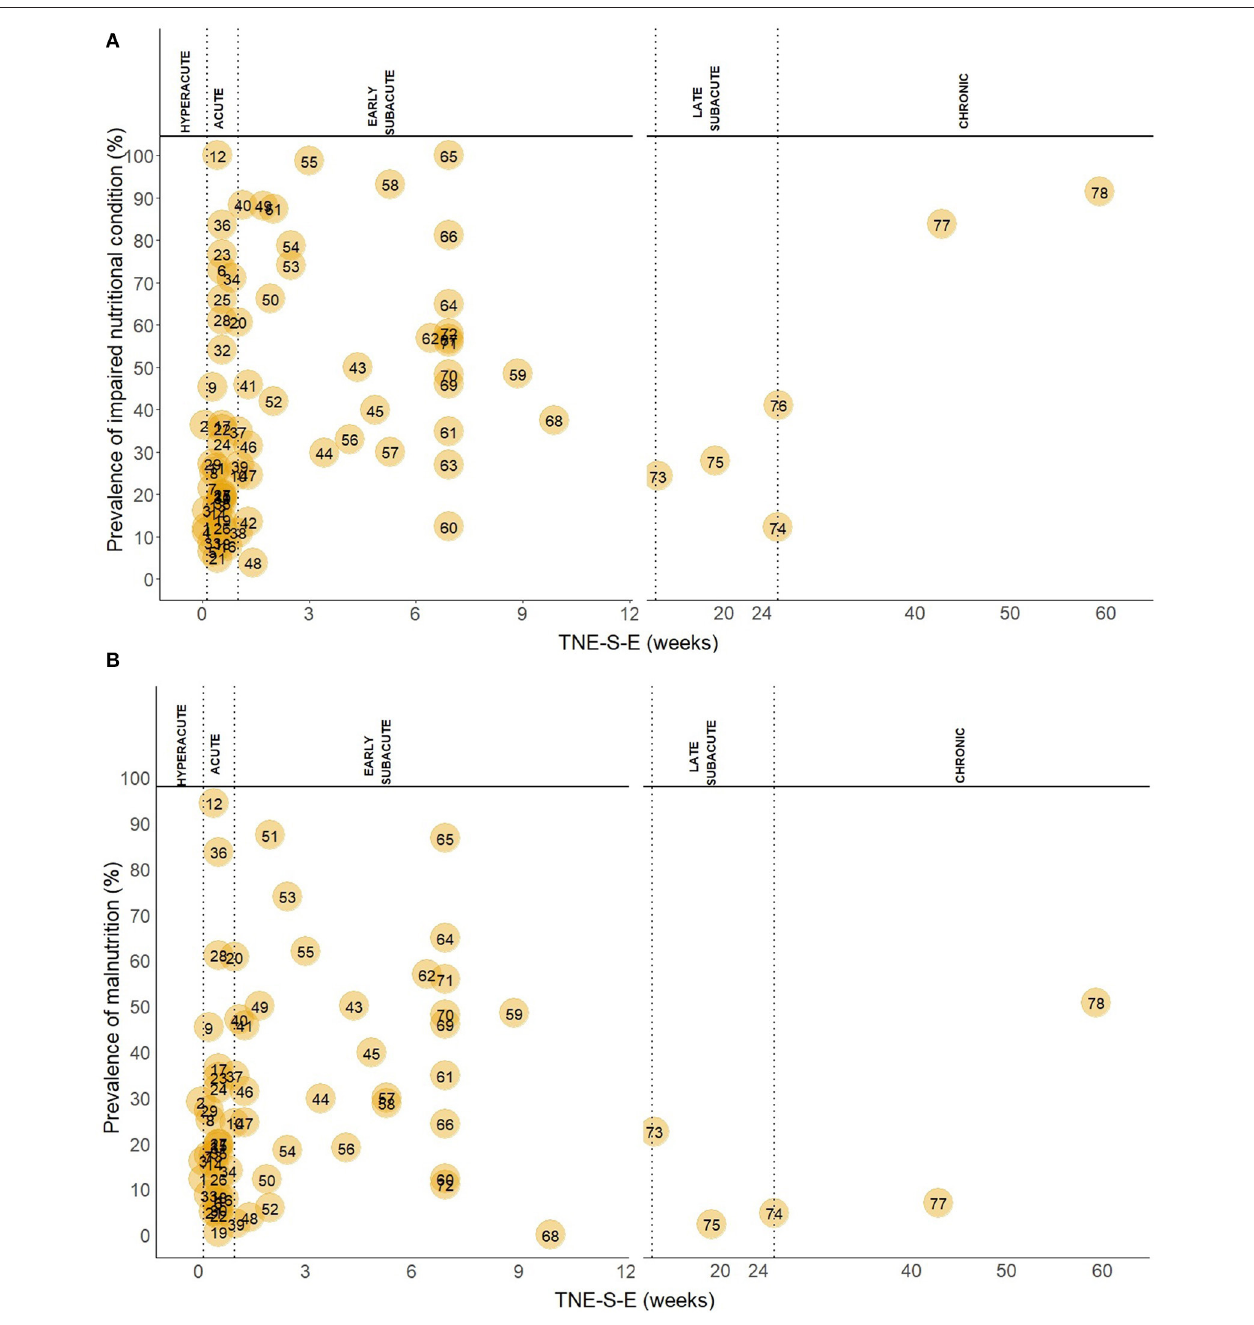
FIGURE 2 | (A) Prevalence of INC in the hyperacute, acute, early subacute, late subacute and chronic phase after stroke. TNE-S-E is shown in a different scale in the hyperacute, acute, and early subacute phase compared to the late subacute and chronic phase. Numbers in the plot indicate the references to the study groups and are listed below. (B) Prevalence of malnutrition in the hyperacute, acute, early subacute, late subacute and chronic phase after stroke. TNE-S-E is shown in a different scale in the hyperacute, acute, and early subacute phase compared to the late subacute and chronic phase. Numbers in the plot indicate the references to the study groups and are listed: 1, Yoo (2); 2, Gomes (3); 3, Davis (32); 4, Kokura (33); 5, Nozoe (34); 6, Nip (8); 7, Sremanakova (35); 8, Diendéré (36); 9, Vajpayee (37); 10, Gandolfo ( 38); 11, Crary (39); 12, NanZhu (40); 13, Zheng I (41); 14, Zheng II (41); 15, Shen (42); 16, Food Trial 2005(b) (43); 17, Xiang (44); 18, Kokura (45); 19, Barrio (46); 20, Otsuki (47); 21, Robertson (48); 22, López Espuela (49); 23, Aliasghari (50); 24, Crary (51); 25, Çoban I (52); 26, Çoban II (52); 27, Schwarz (53); 28, Porter (54); 29, Pandian (55); 30, Mosselman (56); 31, Martineau (57); 32, Ha (58); 33, Food Trial 2005(a) (59); 34, Medin (60); 35, Isono (61); 36, Far (62); 37, Brynningsen (63); 38, Kokura (64); 39, Kang (65); 40, Drozdz (66); 41, Cai (67); 42, Naito (68); 43, Hirano (69); 44, Nishioka 2020(b) (70); 45, Nishioka 2020(a) (71); 46, Kampman I (72); 47, Kampman II (72); 48, Zhang (73); 49, Shiraishi (74); 50, Hsieh (75); 51, Falsetti (76); 52, Sato (77); 53, Lim (78); 54, James (79); 55, Nishioka (80); 56, Aadal (81); 57, Aquilani (10); 58, Nishioka (82); 59, Garbagnati (83); 60, Westergren (84); 61, Poels (85); 62, Hama (86); 63, Maruyama (87); 64, Shimizu (88); 65, Carlsson (89); 66, Tsai (90); 67, Kaur (91); 68, Jung (92); 69, van Zwienen-Pot (93); 70, Campillo (94); 71, Da Silva (95); 72, Lelli (96); 73, Scrutinio (97); 74, Perry (11); 75, Vilardell ( 98); 76, Westergren (99); 77, Choi (100); 78, Kim